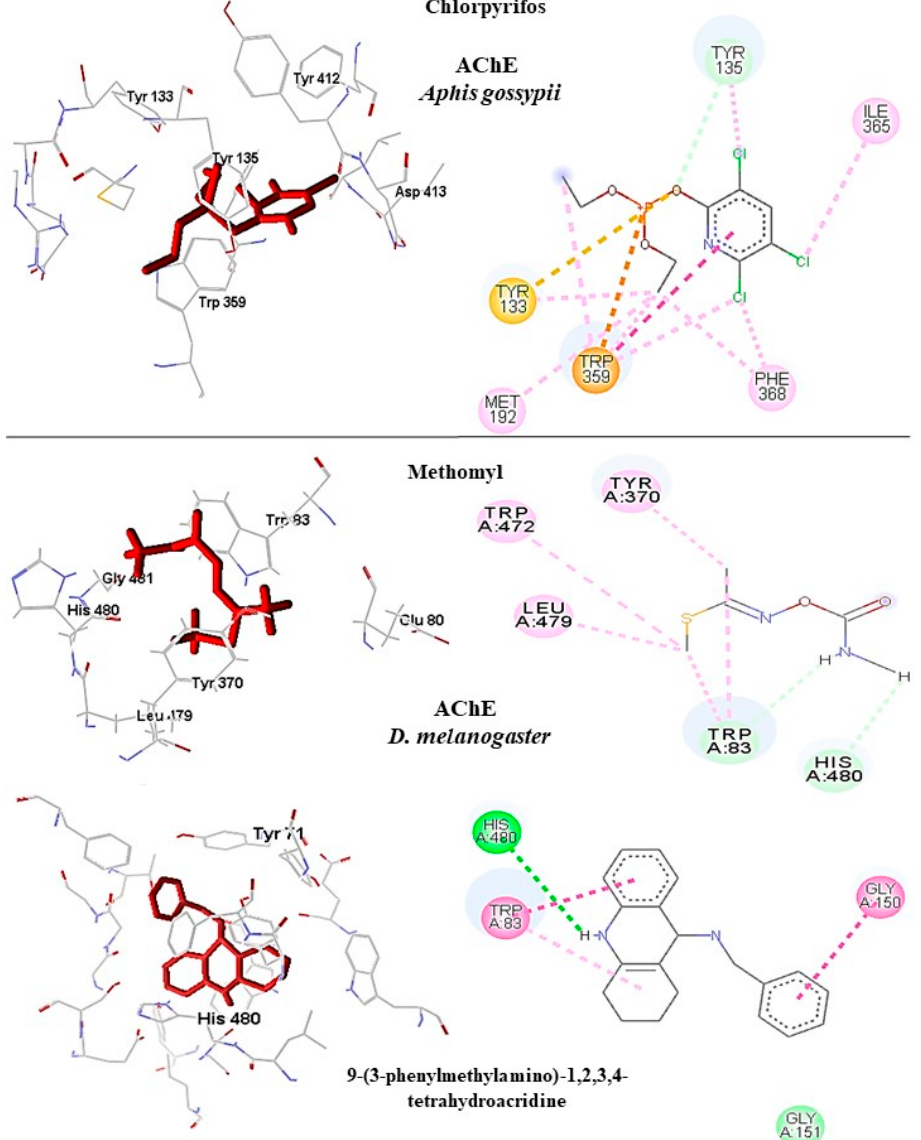
Figure 10. Interactions (3D and 2D) between Chlorpyrifos and A. gossypii -AchE; between both Methomyl and D. melanogaster - AchE, and 9-(3-phenylmethylamine)-1,2,3,4-tetrahydroacridine and D. melanogaster -AchE. Hydrogen bonds are highlighted in green, hydrophobic interactions are highlighted in pink, and steric interactions are highlighted in red.